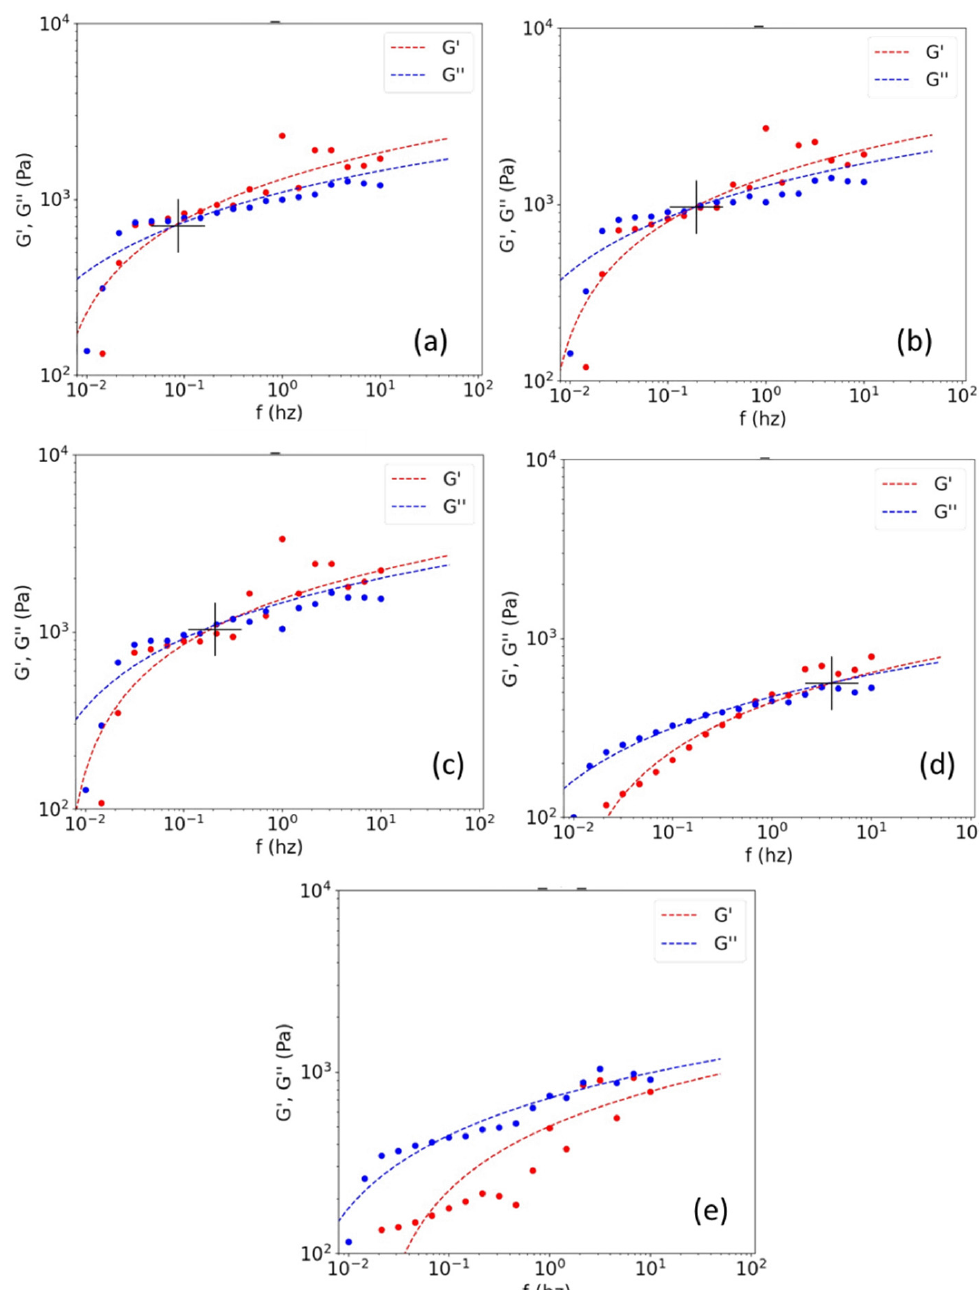
Figure 5. Frequency sweeps and their fittings within the viscoelastic range for the 5% wt sample at